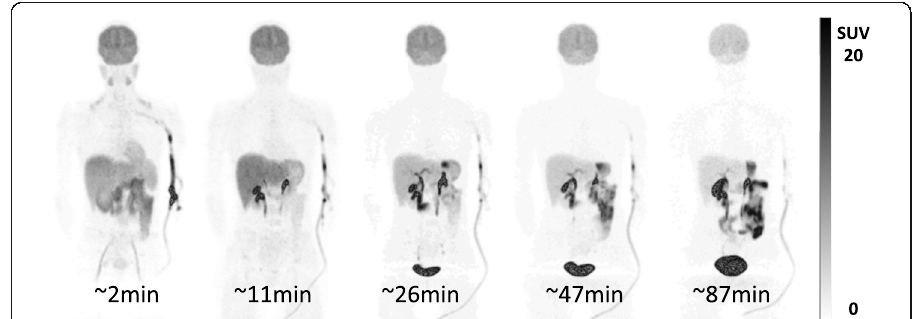
Fig. 1 Maximum intensity projection PET images of subject AN01 showing distribution of radioactivity in whole-body (head to thigh) after injection of 337 MBq of [ 11 C]-UCB-J. High radioactivity uptake is visible in the